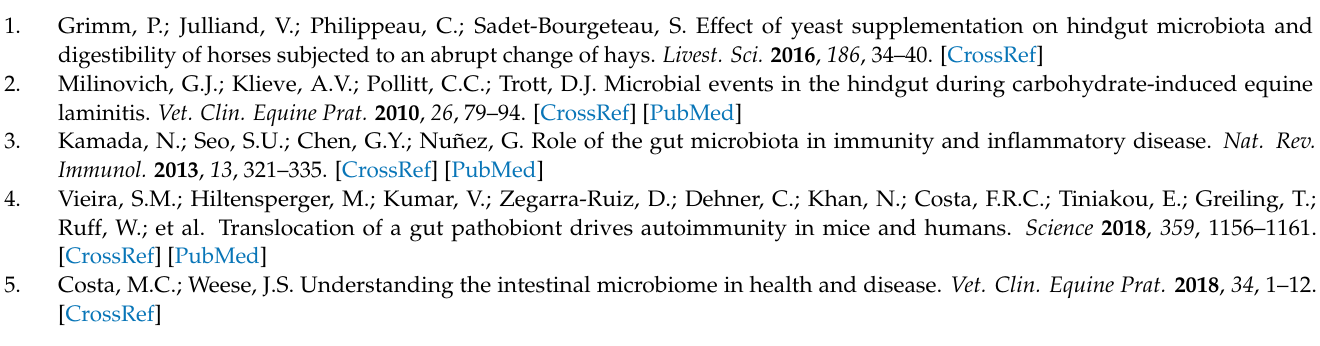
Table S3: Variation in the relative abundance of the bacterial families in the feces of horses 72 h following treatments. Table S4: Variation in the relative abundance of the bacterial genera in the feces of horses 72 h following treatments. Table S5: Pearson’s product-moment correlation between the composition of bacterial phyla found in horses’ fecal microbiota and clinical alterations related to acute laminitis in animals from starch-saline and starch-buffer treatments. Table S6: Pearson’s product-moment correlation between the composition of bacterial families found in horses’ fecal microbiota and clinical alterations related to acute laminitis in animals from starch-saline and starch- buffer treatments. Table S7: Pearson’s product-moment correlation between the composition of bacterial genera found in horses’ fecal microbiota and clinical alterations related to acute laminitis in animals from starch-saline and starch-buffer